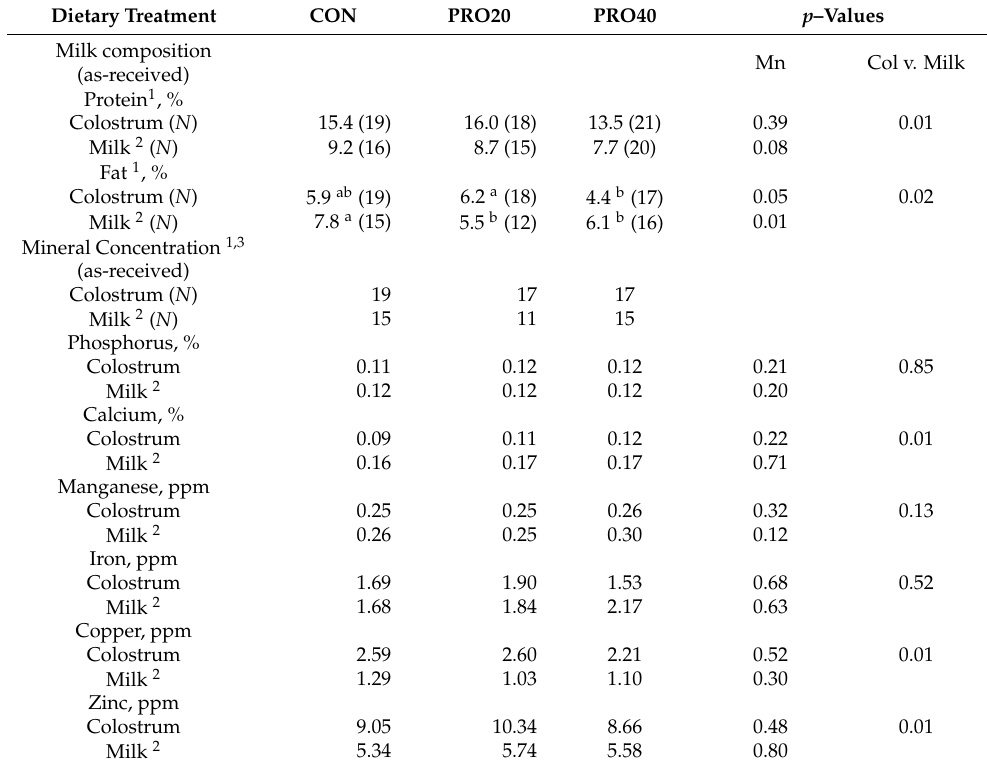
Table 6. The effect of supplemental dietary manganese on the colostrum (d 1) and milk (d 7 and 14) composition of lactating sows. Dietary Treatment CON PRO20 PRO40 p